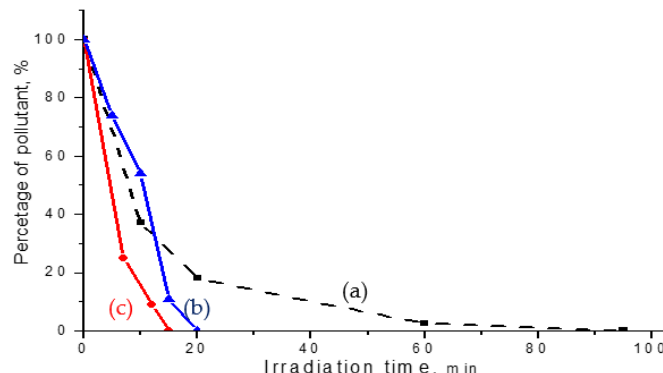
Figure 13. Percentage of the Naphthol green B after different irradiation times in presence of: ( a ) ZA-500, ( b ) NHZ-2-500, and ( c ) NHZ-1-500.